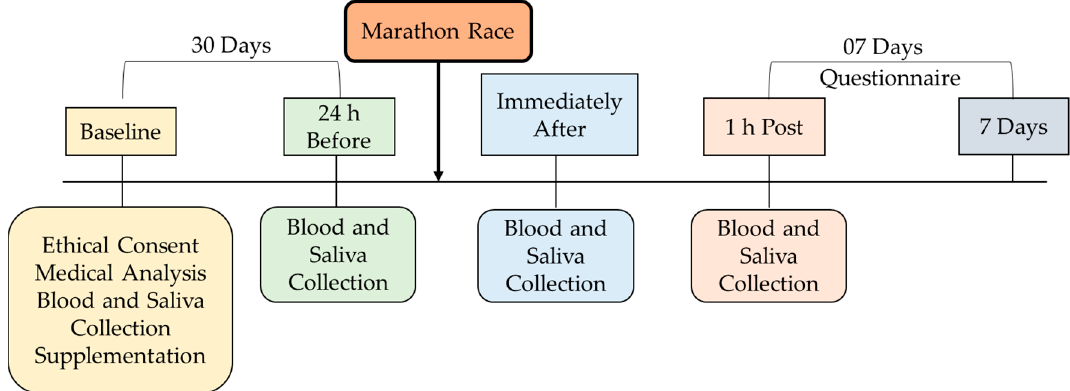
Figure 2. Experimental design.